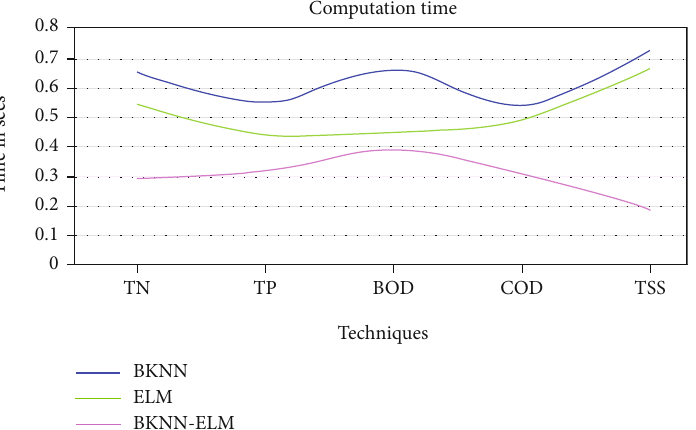
Figure 5: Computation